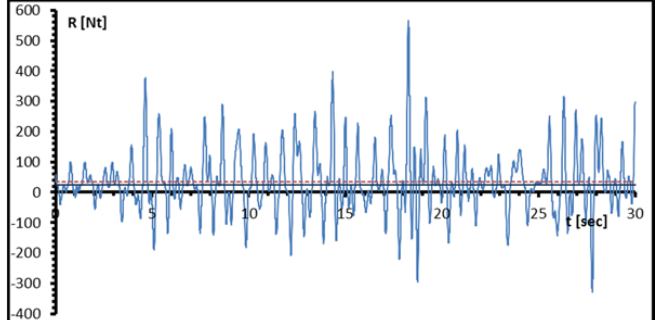
Figure 15. Resistance time series for Experiment #3.